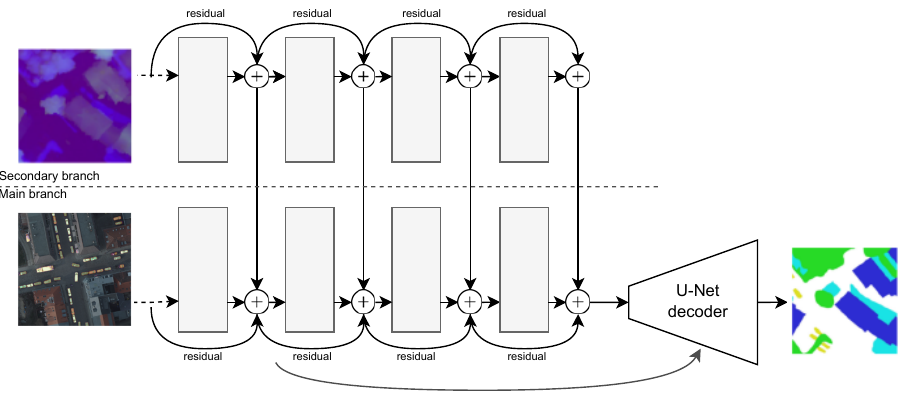
Figure 6. The proposed ReFuse encoder–decoder architecture: the encoder consists of two parallel ResNet-50 networks where every residual block output from the second branch is fused into the main one by a feature map summation. Feature maps from the encoder are then connected with the decoding part by feature map concatenation, such as in the U-Net